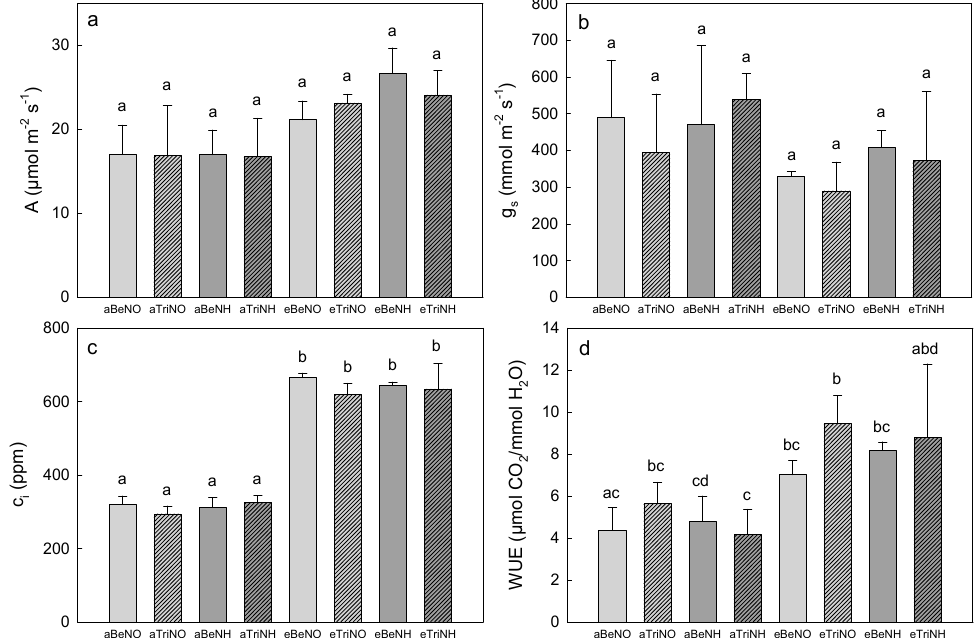
Figure 3. Photosynthetic CO 2 assimilation ( a ), stomatal conductance ( b ), leaf-internal CO 2 concentration ( c ) and photosynthetic water use efficiency ( d ) at harvest (45–46 days after sowing). a = ambient CO 2 , e = elevated CO 2 , Be = ‘Bellezia’, Tri = ‘Tricia’, NO = pure nitrate, NH = ammonium-dominated N. Data are averages of n = 3. Different letters indicate significant differences between the treatments at α = 0.05.